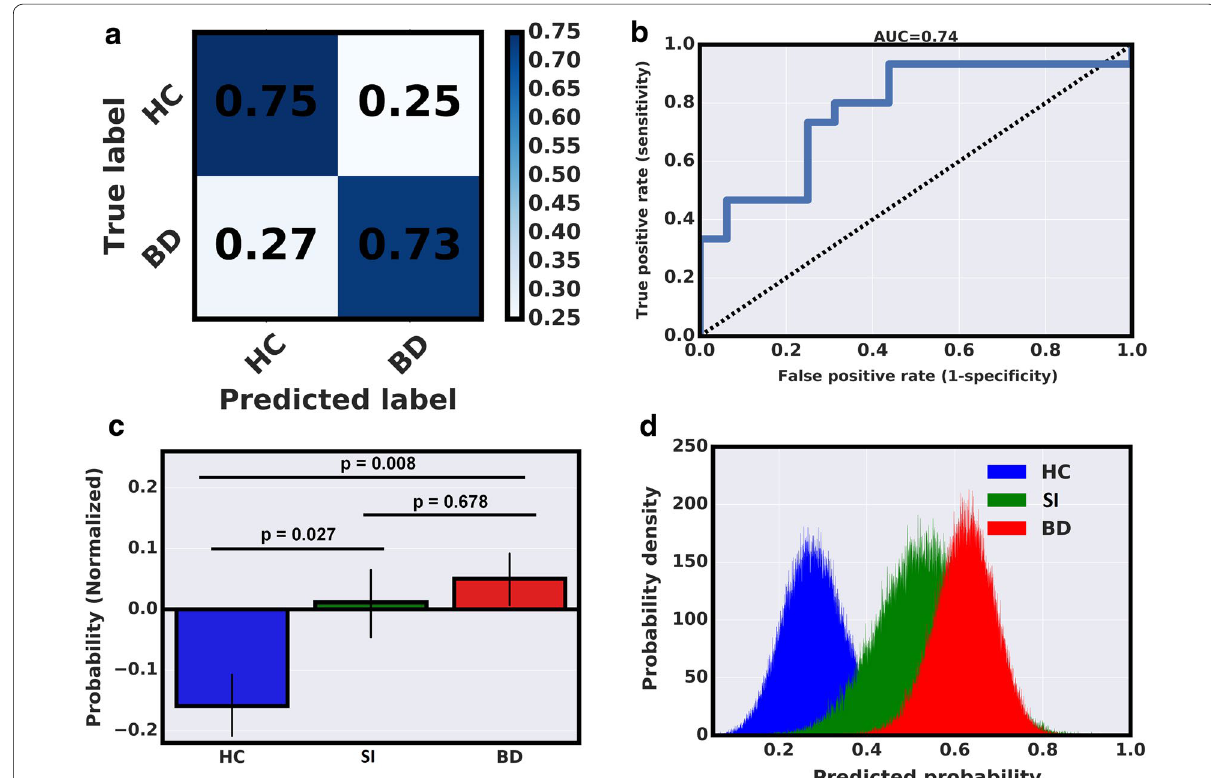
Fig. 4 a A ‘confusion matrix’ representing actual and predicted patient and HCs labels in the replication cohort. b A receiver operating character‑ istic (ROC) curve depicting the algorithm’s performance in distinguishing BD patients from HCs in the replication cohort. c A bar graph comparing predicted probability scores between HCs, SIs, and BD patients HCs in the replication cohort. d A bootstrapping calculation was used to estimate the distribution of the mean predicted probability scores for BD patients, SIs, and